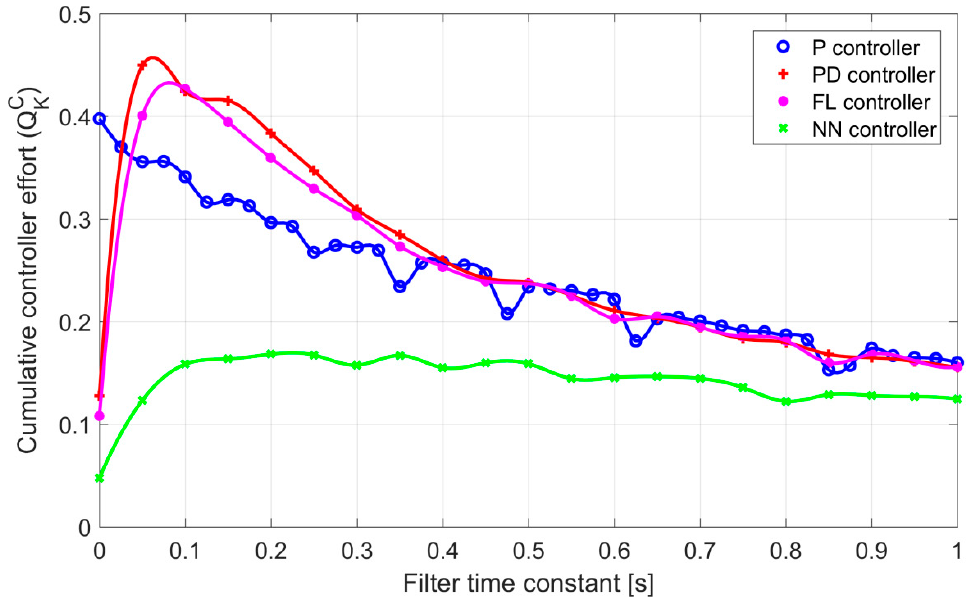
Figure 20. Cumulative effort of the investigated controllers versus filter time constant.